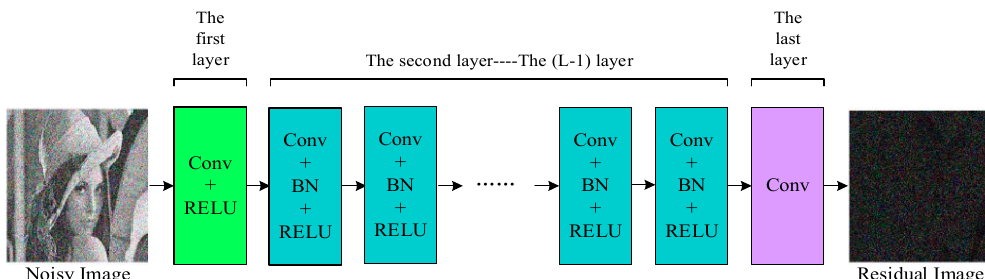
Figure 1. The structure of the proposed convolutional neural network (CNN) denoiser. RELUs: rectified exponential linear units, BN: batch normalization.